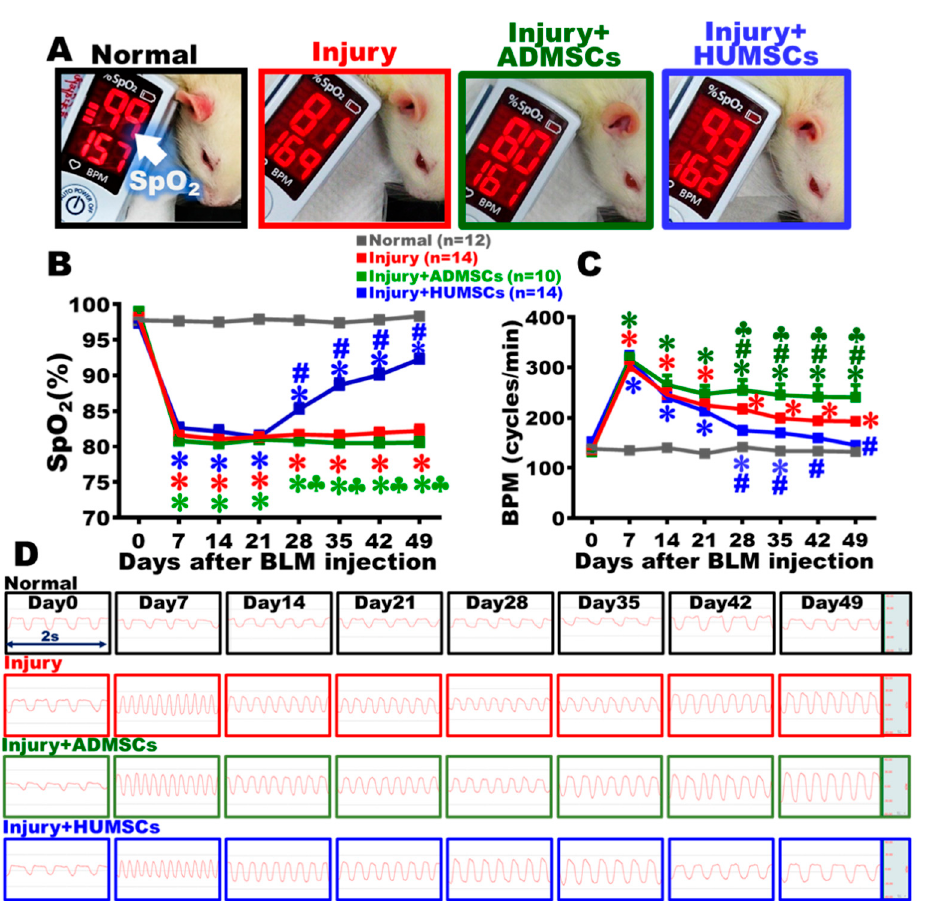
Figure 2. Transplantation of HUMSCs, but not ADMSCs, increased the alveolar volume in PF rats. The horizontal level of the trachea carina is shown in the MRI of the rat thoracic cavity. L stands for the left lung, R for the right lung ( A ). The carina was established as a reference point for image placement. In addition to the carina-containing slice, four images were acquired below the carina. To calculate the left-lung alveolar volume for each rat, the fi ve pictures were added together and the black alveolar space was quanti fi ed. The black alveolar space in these fi ve images was quanti fi ed to represent the left-lung alveolar volume of each rat. The fi ndings indicated that the alveolar volume drastically decreased following BLM damage. The alveolar volume was signi fi cantly increased by HUMSCs transplantation ( B ). Weekly weighing showed that HUMSCs transplantation improved the body weight of rats with PF ( C ). The fi gure shows the number of rat samples in each group. ✽ : p < 0.05 (vs. the Normal group); #: p < 0.05 (vs. the Injury group); ♣ : p < 0.05 (the Injury+ADMSCs group vs. the Injury+HUMSCs group).